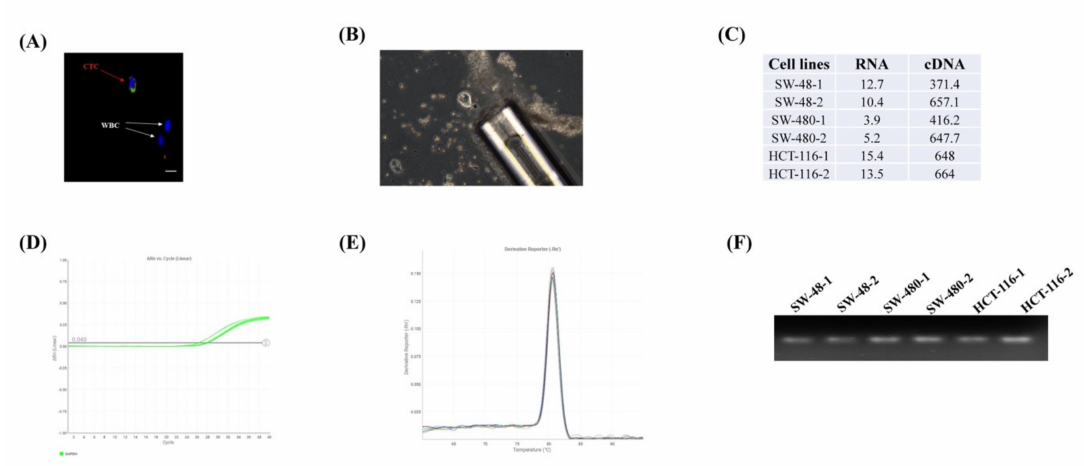
Figure 1. Assessment of the gene expression profiling from the single cell. ( A ) Identification of the circulating tumour cell (CTC) from the other blood cells e.g. white blood cells (WBCs) ( B ) Isolation of single CTC. ( C ) The concentration and cDNA concentration (ng / µ L) of the six cells from three colon cancer cell lines (SW-48, SW-480 and HCT-116). The RNA integrity was carried out by assessing the gene expression of glyceraldehyde 3-phosphate dehydrogenase (GAPDH) showing ( D ) Ct values of < 30 and ( E ) a single peak in the melting curve. (F) PCR product was run in 2% agarose gel to confirm the qPCR